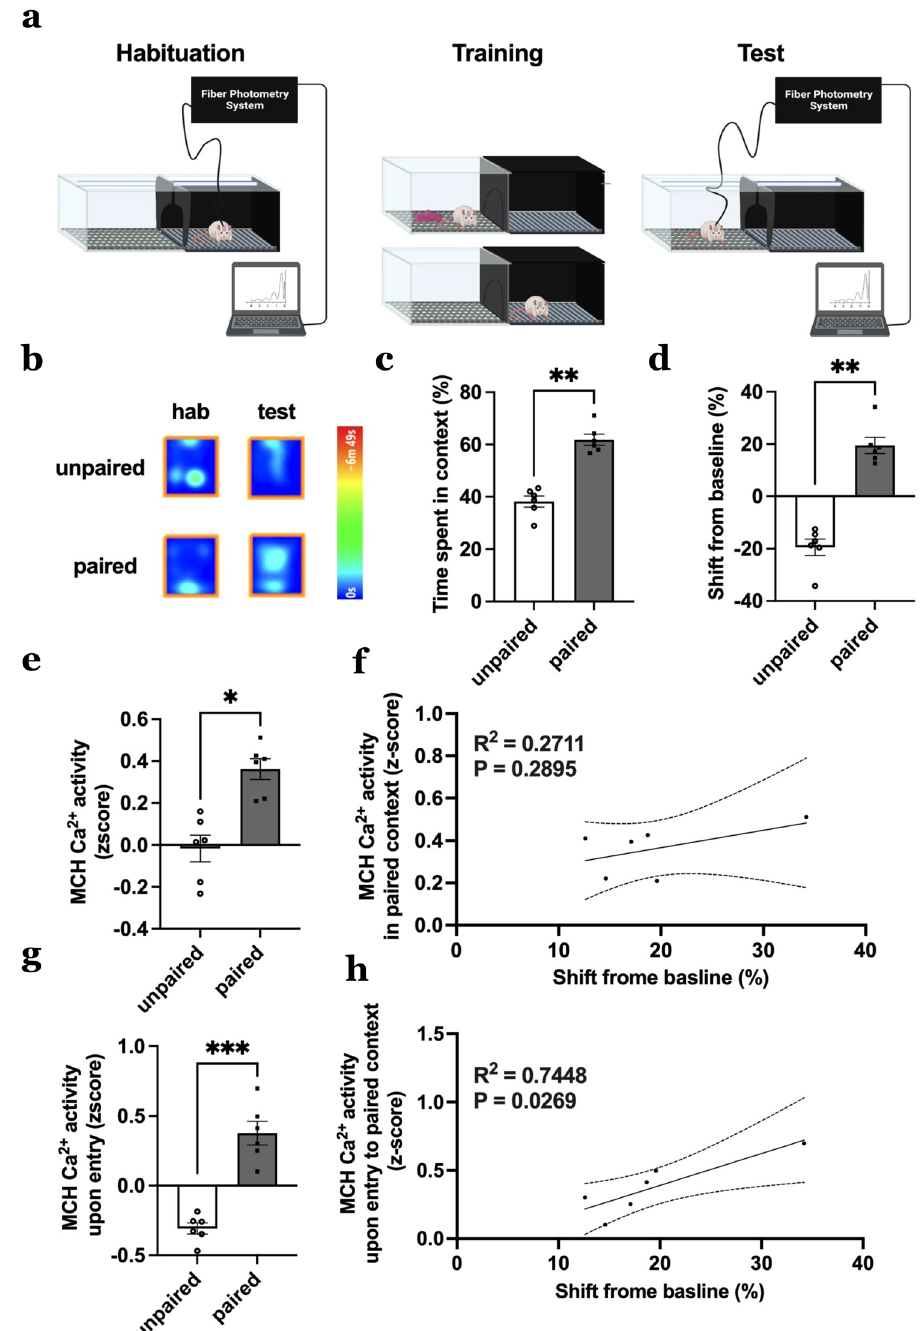
Fig. 2 | Physiological MCH neuron Ca 2+ activity increases in response to contextual-based food-predictive cues and is associated with food-seeking memory behavior. a Schematicdiagram depicting fi ber photometryrecording of MCHneuronCa 2+ activityduringconditionedplacepreference(CPP)inrats( n =6). b Representative heat maps (single animal) depicting the time spent on the food- paired or unpaired side during habituation and test day. The less preferred side during habituation is assigned as the food-paired side during training. c , d CPP behavior data during the test phase (data analyzed using Student ’ s two-tailed paired t -test, n =6 rats), with c percentage time spent on a side, ** P =0.0027 and d shiftfrombaseline(differenceinpercentagetimespentonthesidebetweenpre- and post-training), ** P =0.0016. e – h Fiber photometry recording of MCH neuron